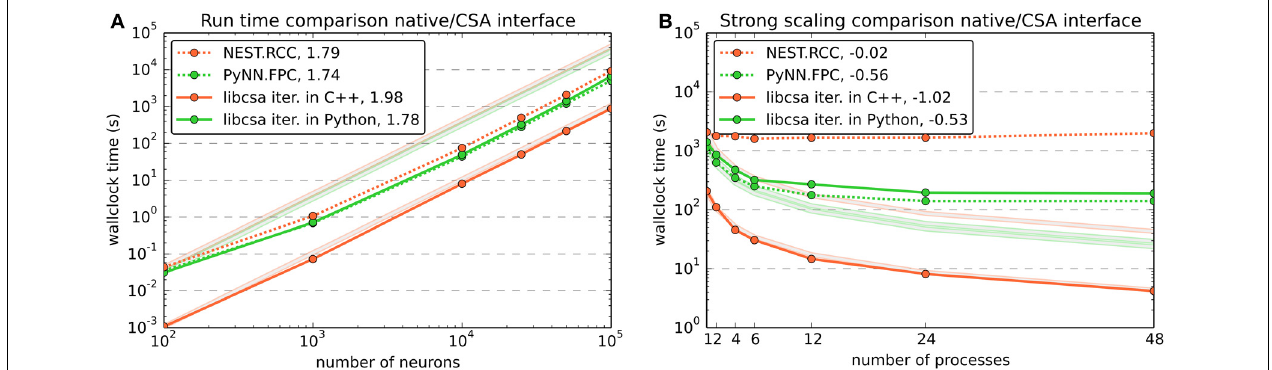
FIGURE 5 | Benchmark results comparing the use of CSA in NEST through PyNN and the native interfaces for random connectivity in PyNN and NEST. Color and dash codes are given in the legends. Slope is the ratio of logarithms of the last and first data point shown. Pale lines denote the expected scaling. PyNN.FCC corresponds to PyNN’s FixedProbabilityConnector , nest.RCC to NEST’s function RandomConvergentConnect . (A) Shows the run time for connecting a network of different numbers of neurons. The number of connections